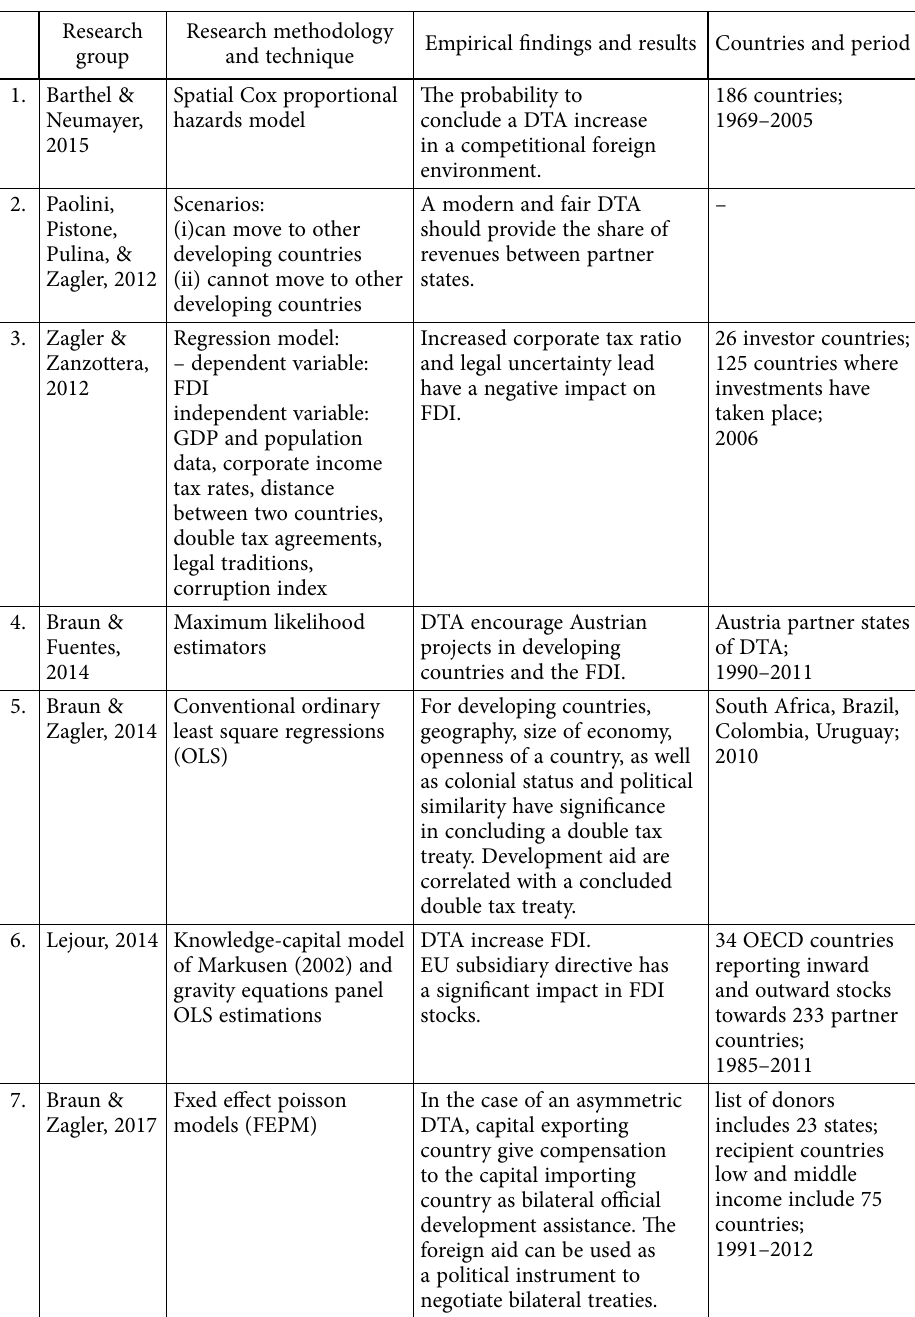
Table 1. Previous empirical studies regarding double taxation conventions (source: own processing) Research